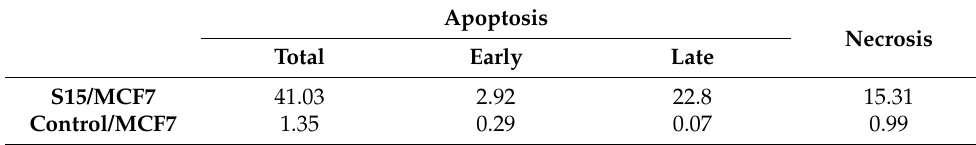
Table 4. Effect of compound S15 treatment of MCF7 cancer cell line on necrosis and